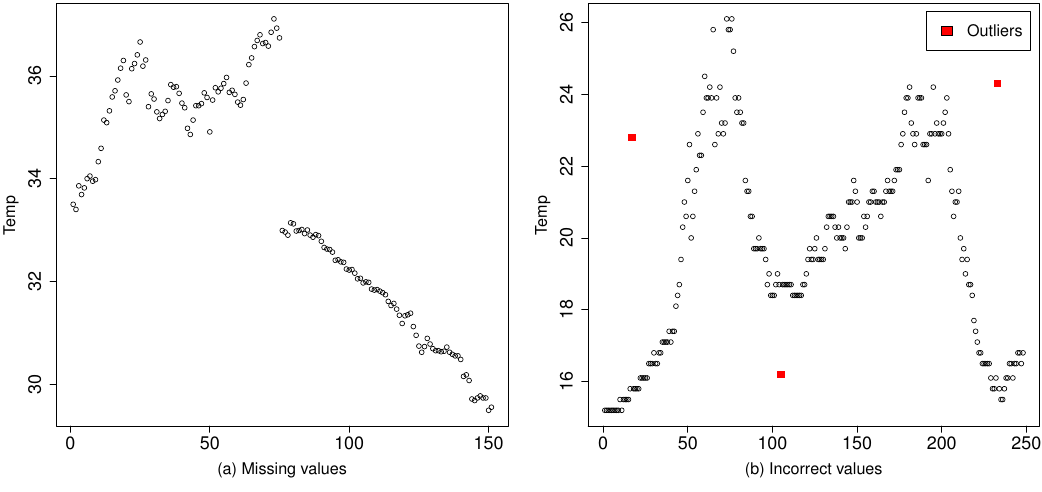
Figure 1. Examples of outliers: ( a ) from missing observations; and ( b ) from abnormal